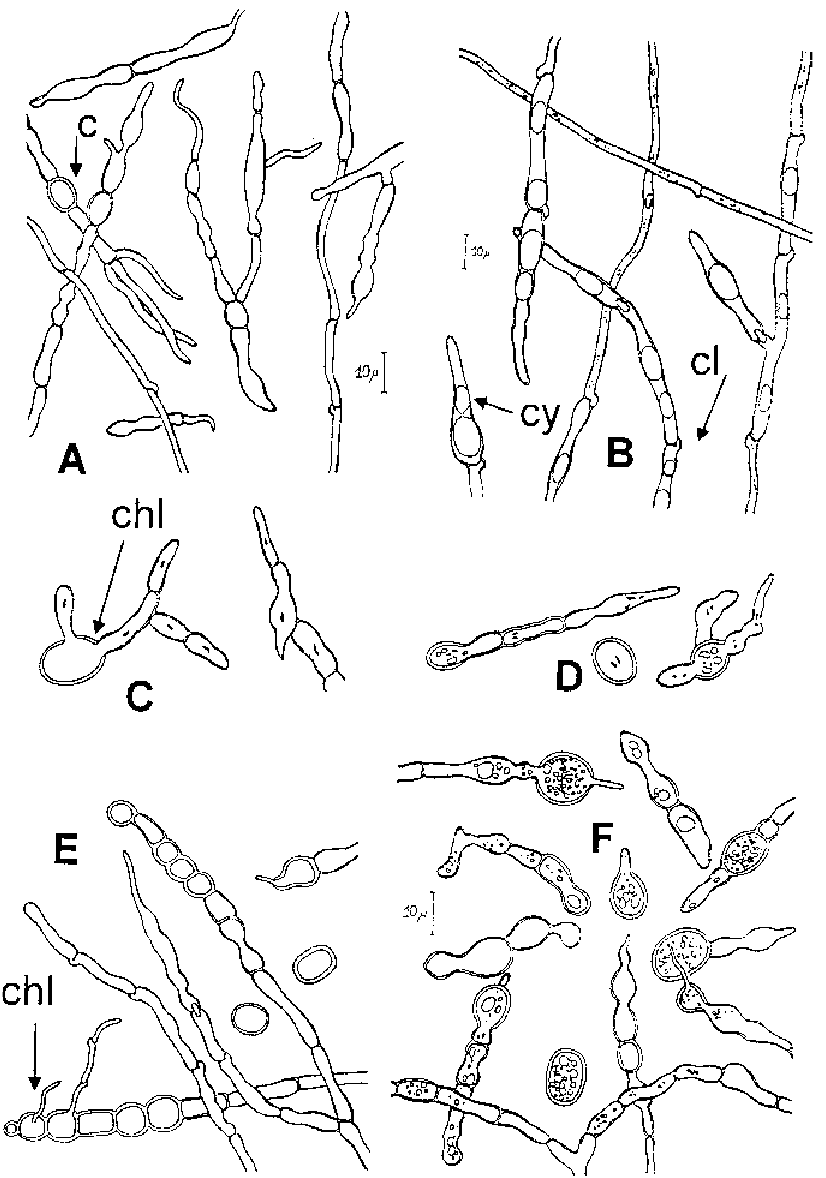
Fig. 2: Rickenella fibula in mycelial culture: A) dicaryotic mycelium; some clamps are visible at the septa of hyphae. In some hyphae a transition to short, rather broad and clamp less hyphae occurred; some of them form thick walled elliptic chlamydospores (chl); B) dicaryotic, clamped hyphae (cl); some of them inflated and vacuolized. Terminal elements sometimes similar to cystidia (cy); C) monocaryotic hyphal segments formed by germinating chlamydospores (chl); D) dicaryotic hy phae formed by germinating chlamydospores; E) chains of chlamydospores partially germinating with dicaryotic hyphae; F) chlamydospores and their hyphal outgrowths; taken from a culture with Peziza like